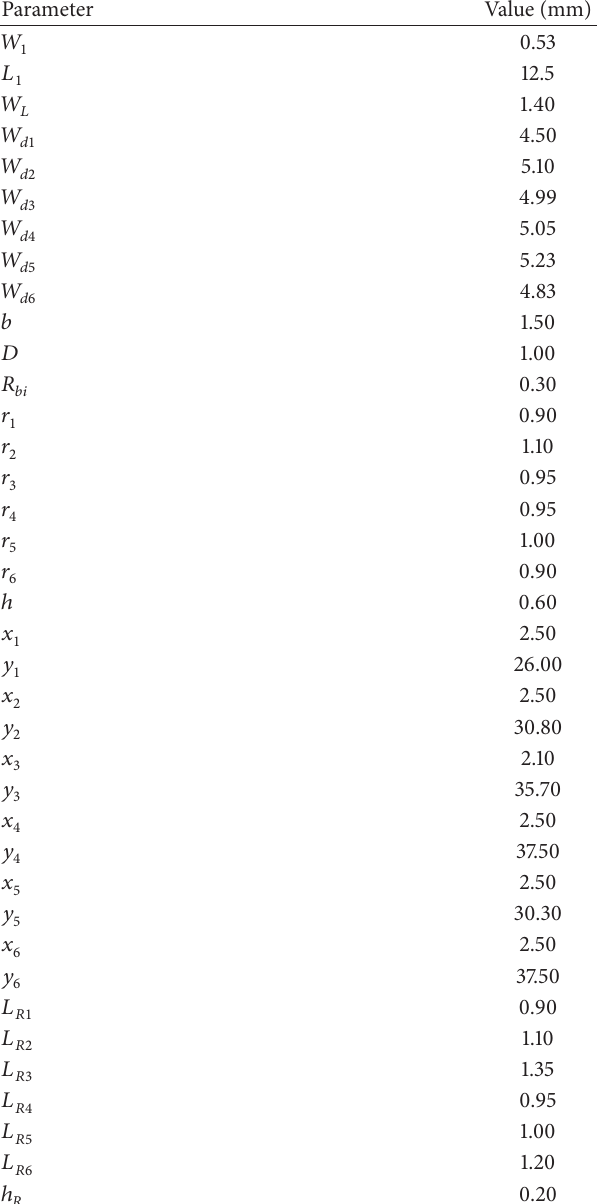
Table 1: The parameter values of the proposed